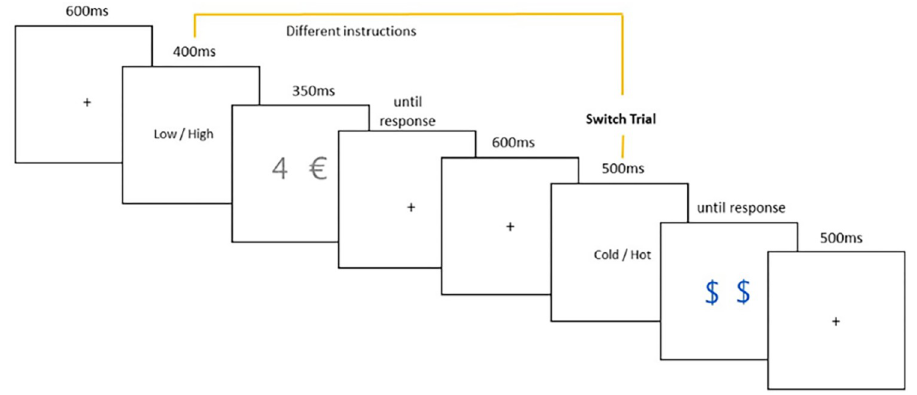
Fig 4. Example of a single